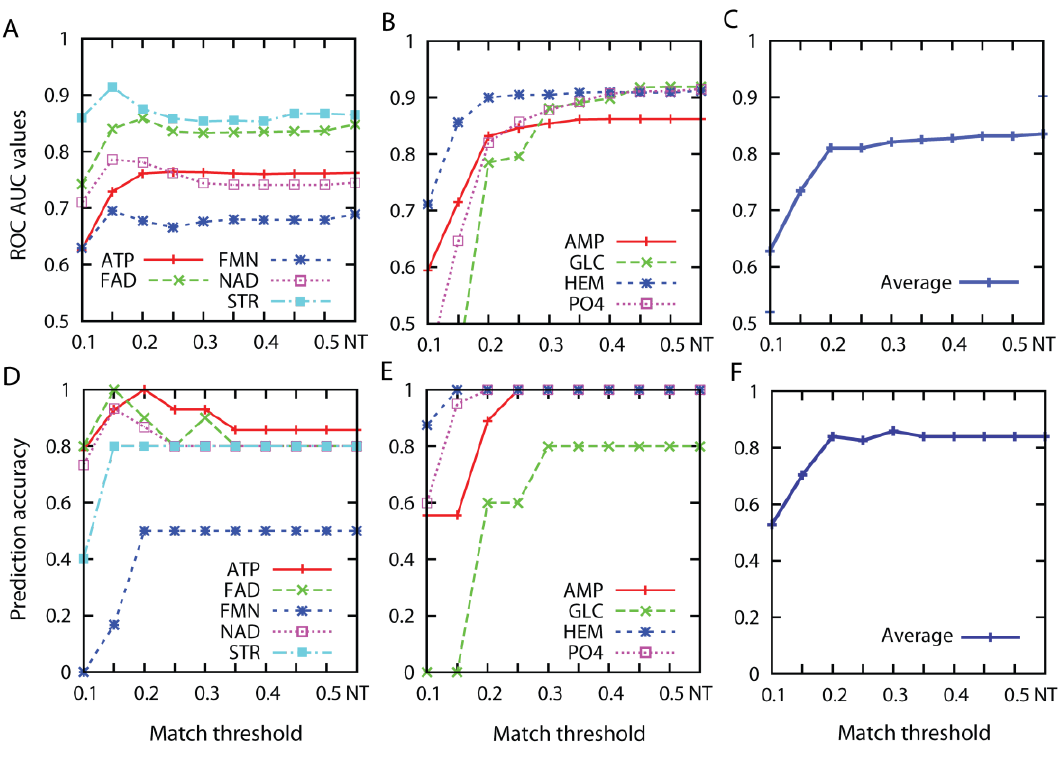
Figure 4. Prediction performance using shape and pocket size information. ROC AUC values of pockets that bind to ( A ) ATP, FAD, FMN, NAD, and STR; ( B ) AMP, GLC, HEM, and PO4. ( C ) Average ROC AUC values over all ligand types. Top-3 prediction success rate of ( D ) ATP, FAD, FMN, NAD, and STR; ( E ) AMP, GLC, HEM, and PO4. ( F ) Average Top-3 success rate over all ligand types. *NT in x-axis denotes experiments with no threshold